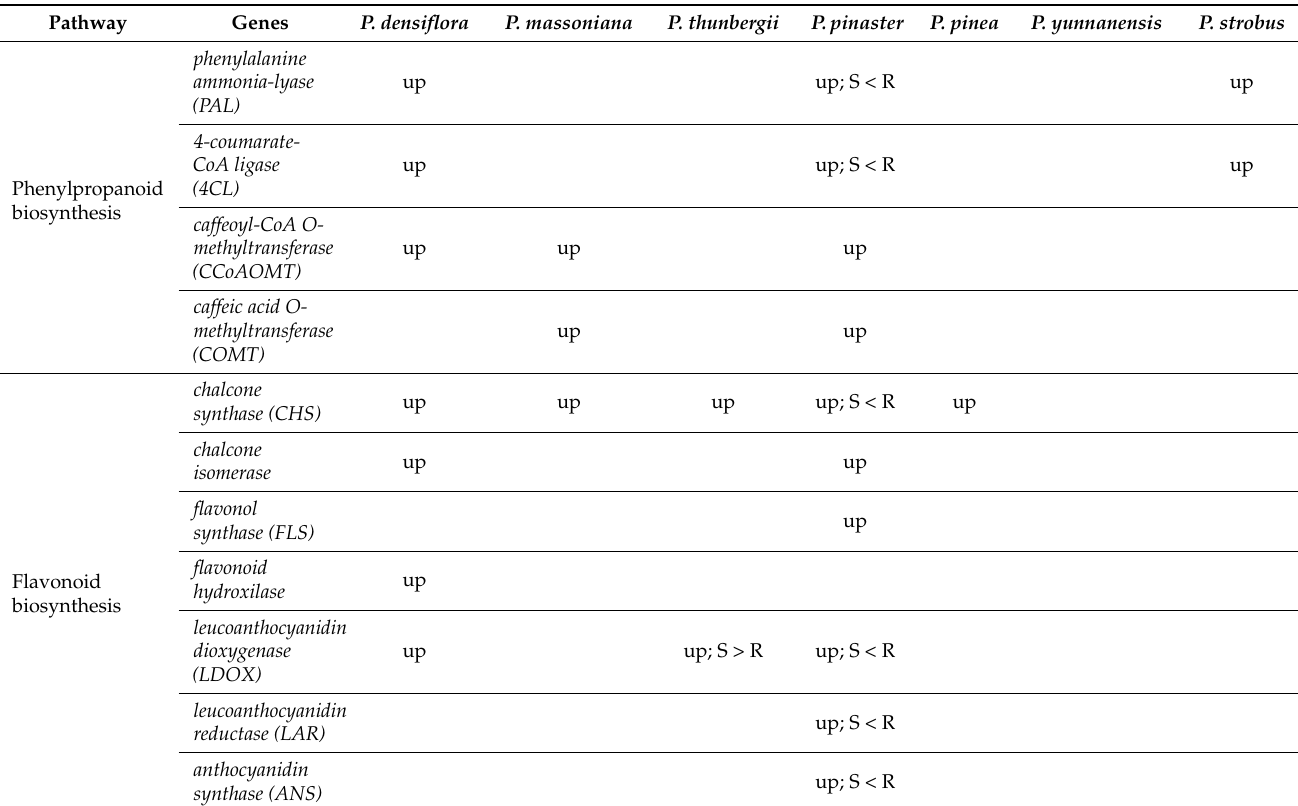
Table 3. Expression of genes related to secondary metabolism pathways in several pine species after inoculation with pinewood